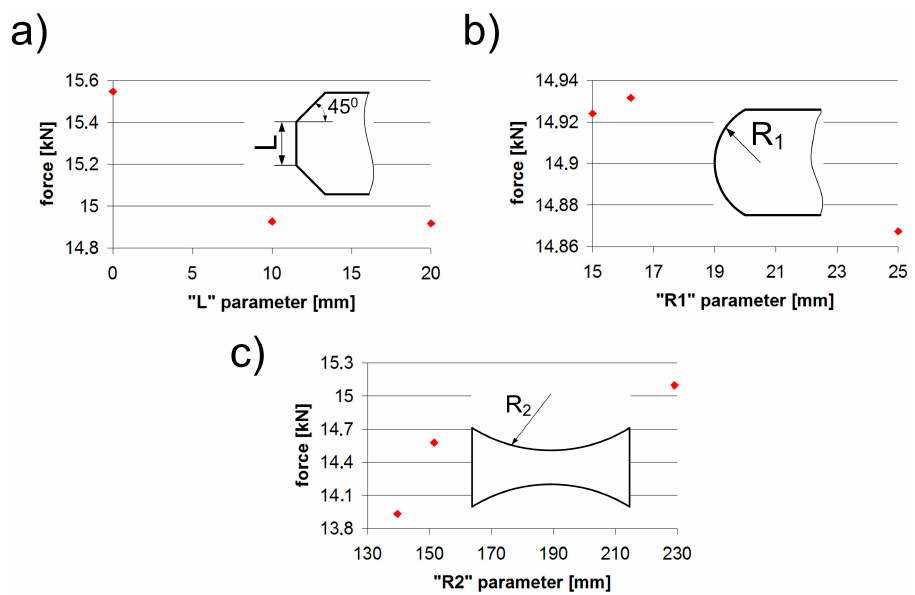
Figure 7. Influence of: ( a ) the chamfer (L), ( b ) the fillet radius (R1), and ( c ) the thinning radius (R2) parameters in HJs.